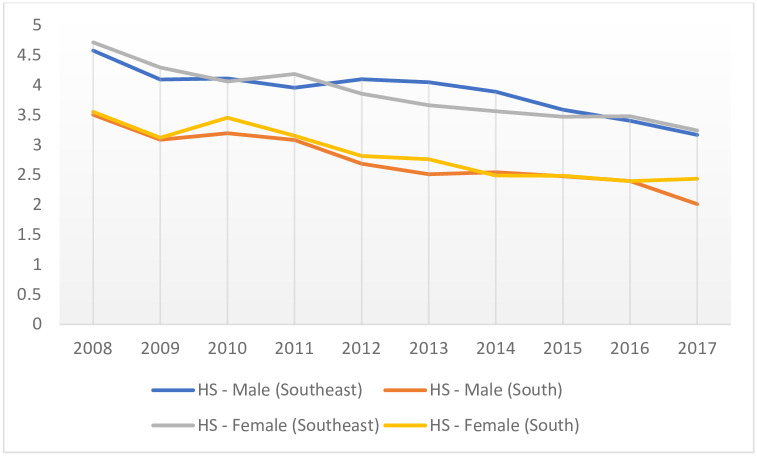
Temporal trend of the mortality (x100,000 inhabitants) due to hemorrhagic stroke, stratified by gender of young adults, residents of developed regions of Brazil, 2008–2017.HS—Hemorrhagic Stroke; x-axis: years; y-axis: mortality rates.